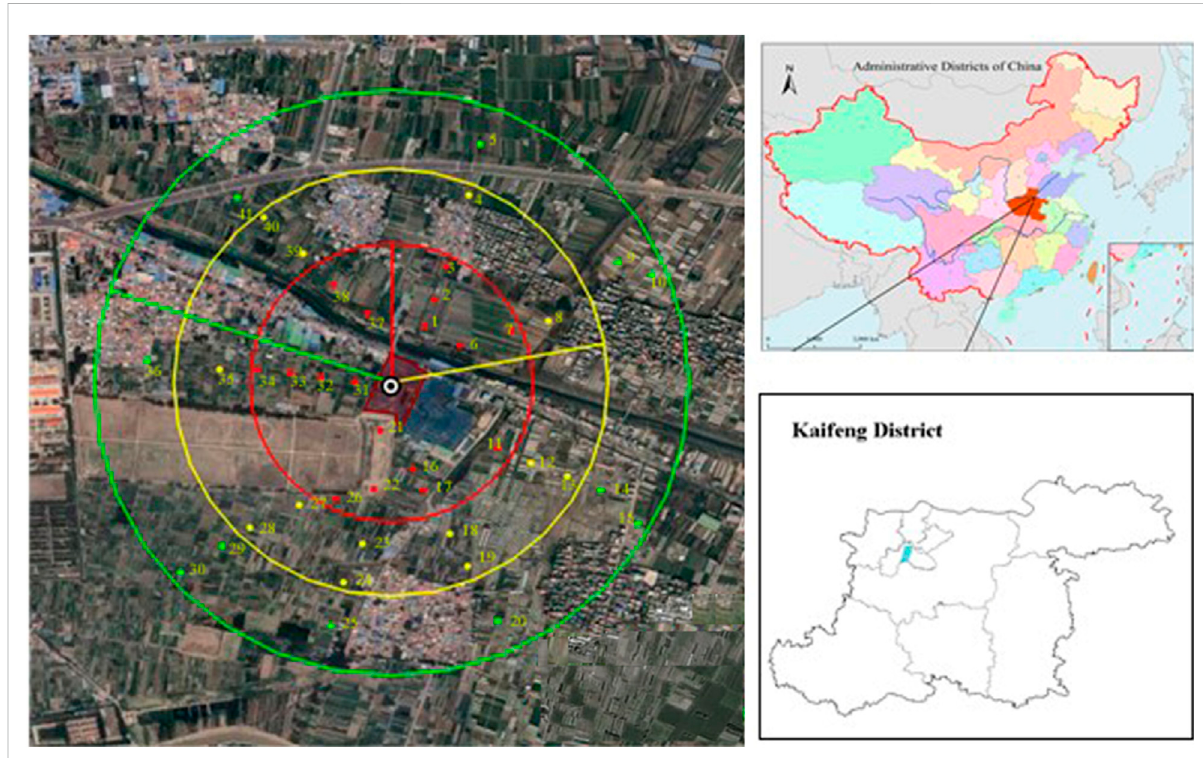
FIGURE 1 Map of the study area and distribution of sampling points. *The center of the concentric circle is the waste